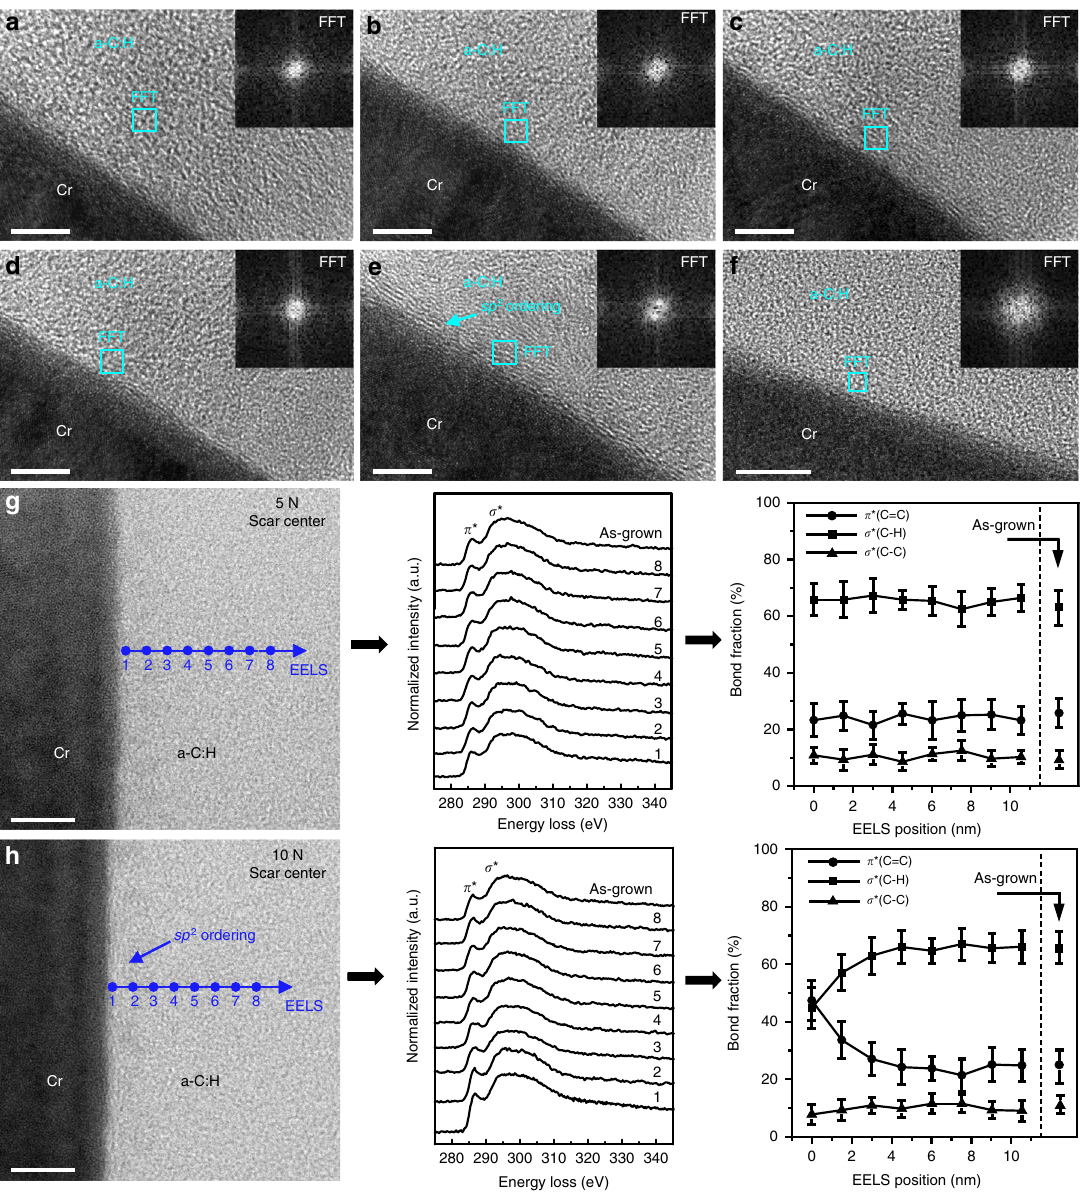
Fig. 2 Characterization of the contact areas for self-mated a-C:H (ACF-1) surfaces. The corresponding superlubricity tests at various normal loads are shown in Supplementary Fig. 2. a HRTEM image of the as-grown a-C:H fi lm on SUJ2 steel ball. (Inset) FFT image derived from the square bright-blue box (2 nm × 2 nm) shows the typical amorphous character of the fi lm. b – f HRTEM images showing the bonding structures of the sliding interfaces from different contact areas: b ball wear scar center at 2 N, c ball wear scar center at 5 N, d ball wear scar edge at 10 N, e ball wear scar center at 10 N and f wafer wear track center at 10 N. (Insets) FFT images obtained from the local 2 nm × 2 nm bright-blue boxes indicate the structural evolution of the outer- most sliding interfaces. Scale bars in a – e and f are 5 and 10 nm, respectively. The initial peak Hertz contact pressures under loads of 2, 5 and 10 N are 0.68, 0.93 and 1.17 GPa, respectively. g BF-STEM image and EELS results indicating the nearly intact bonding structure of the a-C:H layer near the sliding interface for the scar center at 5 N. h BF-STEM image and EELS results con fi rming the sp 2 clustering and ordering in the outer-most ~ 3 nm region near the sliding interface for the scar center at 10 N. Scale bars in g and h , 5 nm. Error bars in g and h represent s.d. of calculated carbon bond